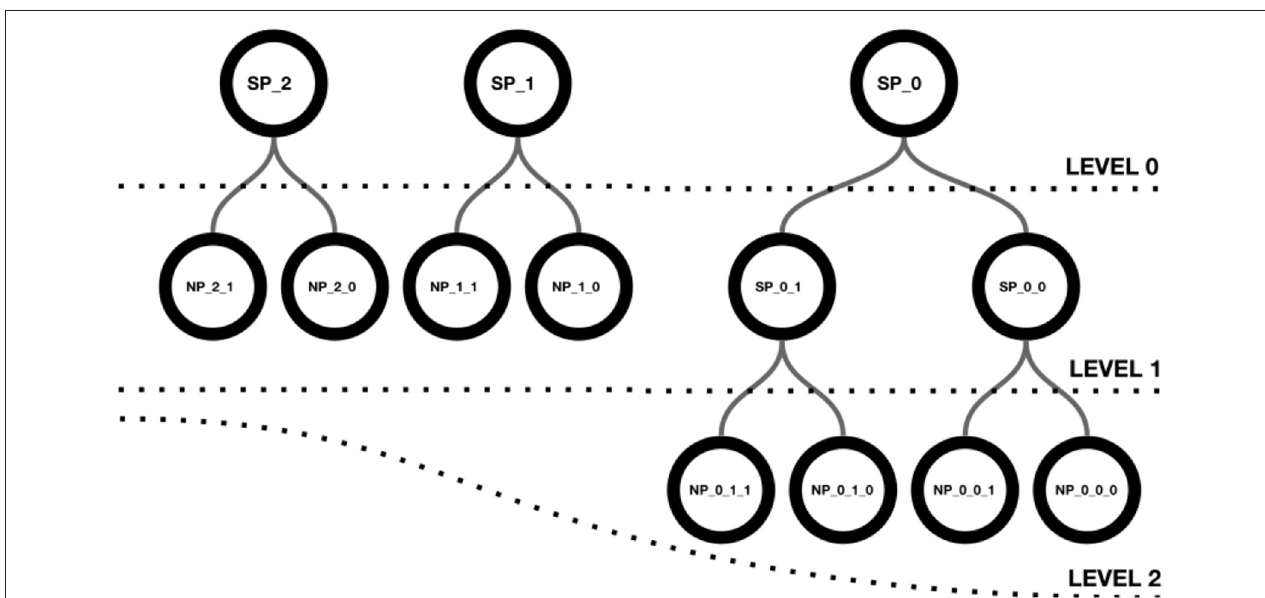
FIGURE 1 | Hierarchical structure of a scene. Level 0 shows three superpopulations that group either populations or descendant superpopulations, as shown in level 1. Superpopulations SP_0_0 and SP_0_1 contain two neuron populations each, as depicted in level 2.